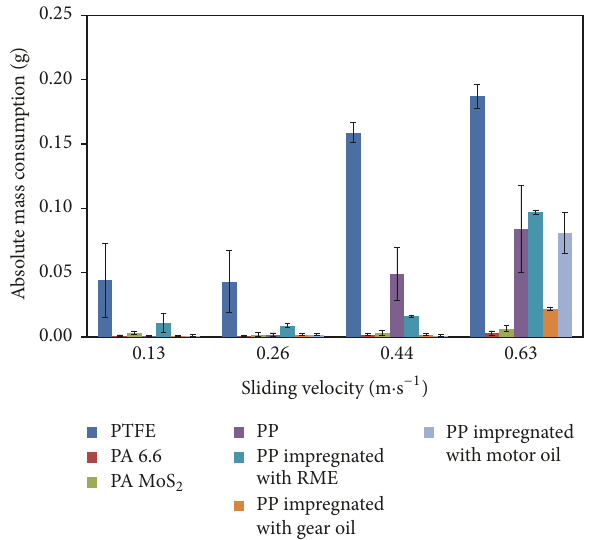
Figure 6: Average value of absolute mass consumption of the tested polymers for various sliding velocities: 0.13, 0.26, 0.44, and 0.62 m ⋅ s −1